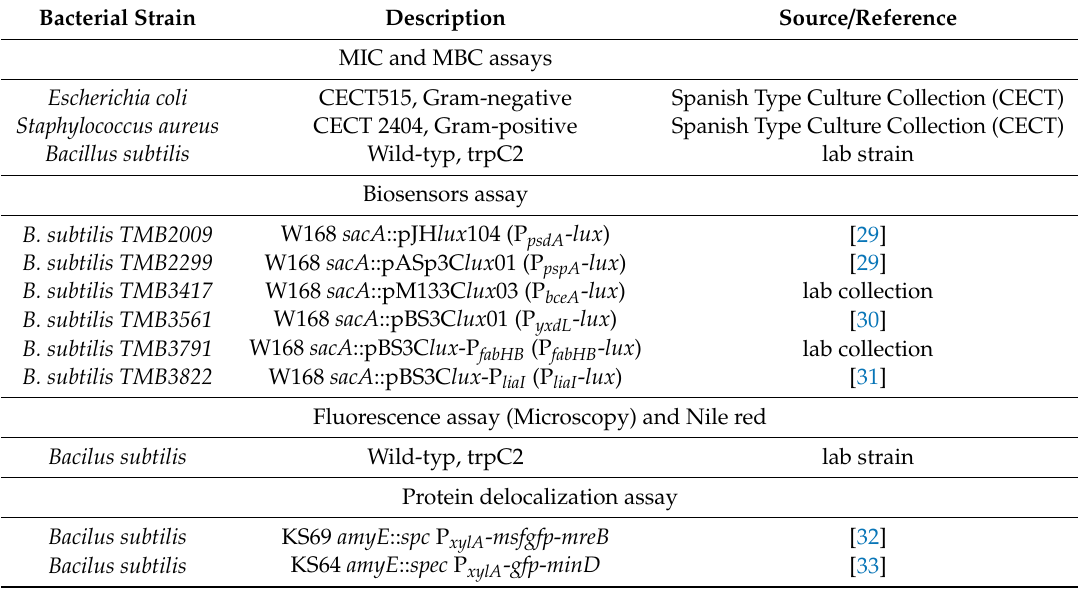
Table 1. Bacterial strains used for di ff erent microbiological